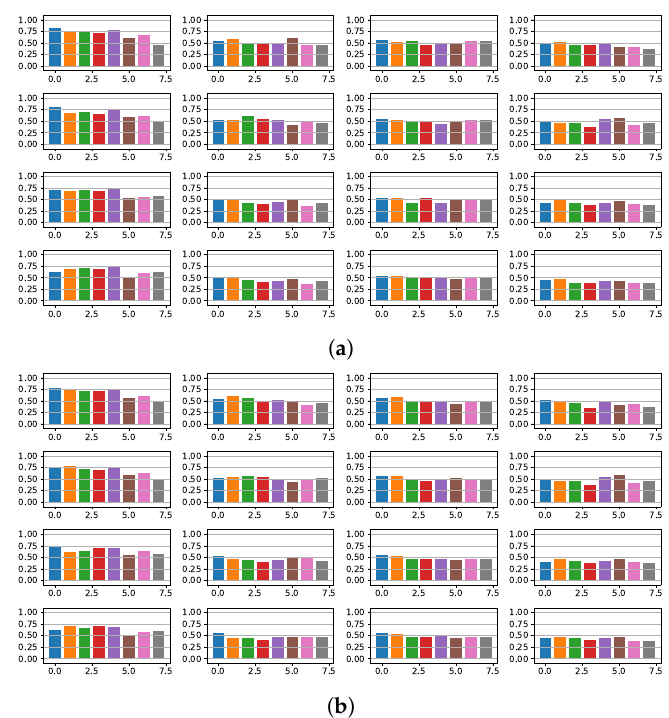
Figure 6. Accuracy of linear SVM applied over SWfrag-DB. (See Figure 5 for details) ( a ) ν -SVM implementation. ( b ) C-SVM